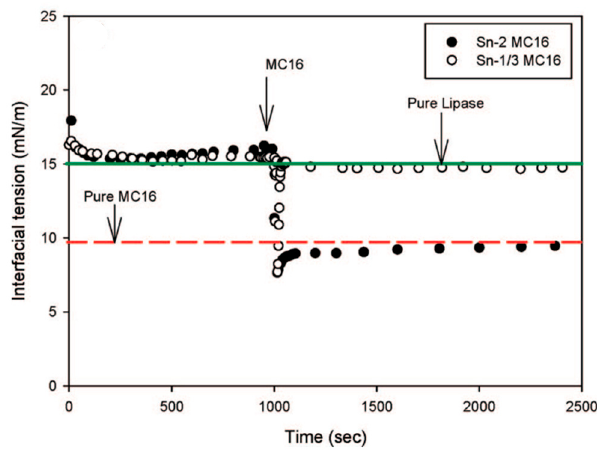
Figure 11. The interfacial tension of lipase-adsorbed layers at the buffer–decane interface followed by the injection of 6.7 × 10 − 4 M Sn-2 monopalmitin and Sn-1/3 monopalmitin. The green and red lines show the equilibrium IFT for pure lipase and pure Sn-2 monopalmitin; reprinted with permission from [110].